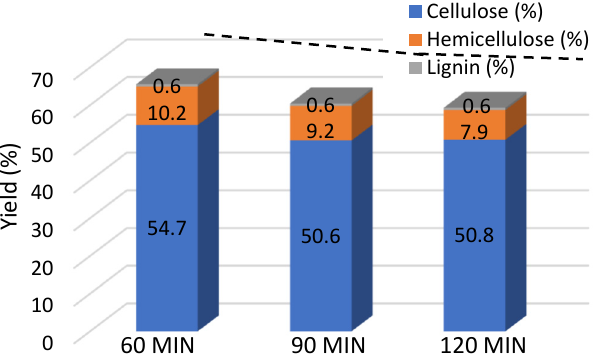
Figure 4. Chemical composition of kenaf outer bast with different reaction times of acid hydrolysis with 0.5 N sulfuric acid at 110 °C.